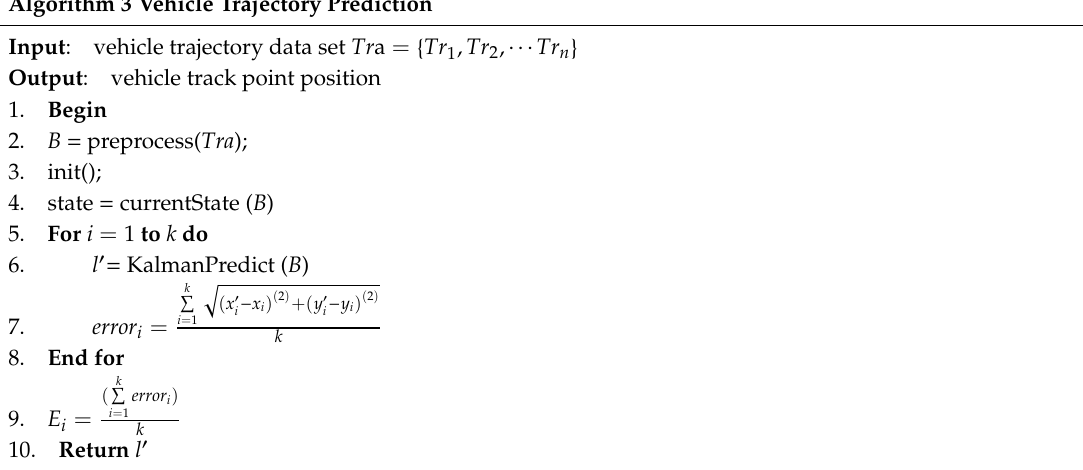
Algorithm 3 Vehicle Trajectory